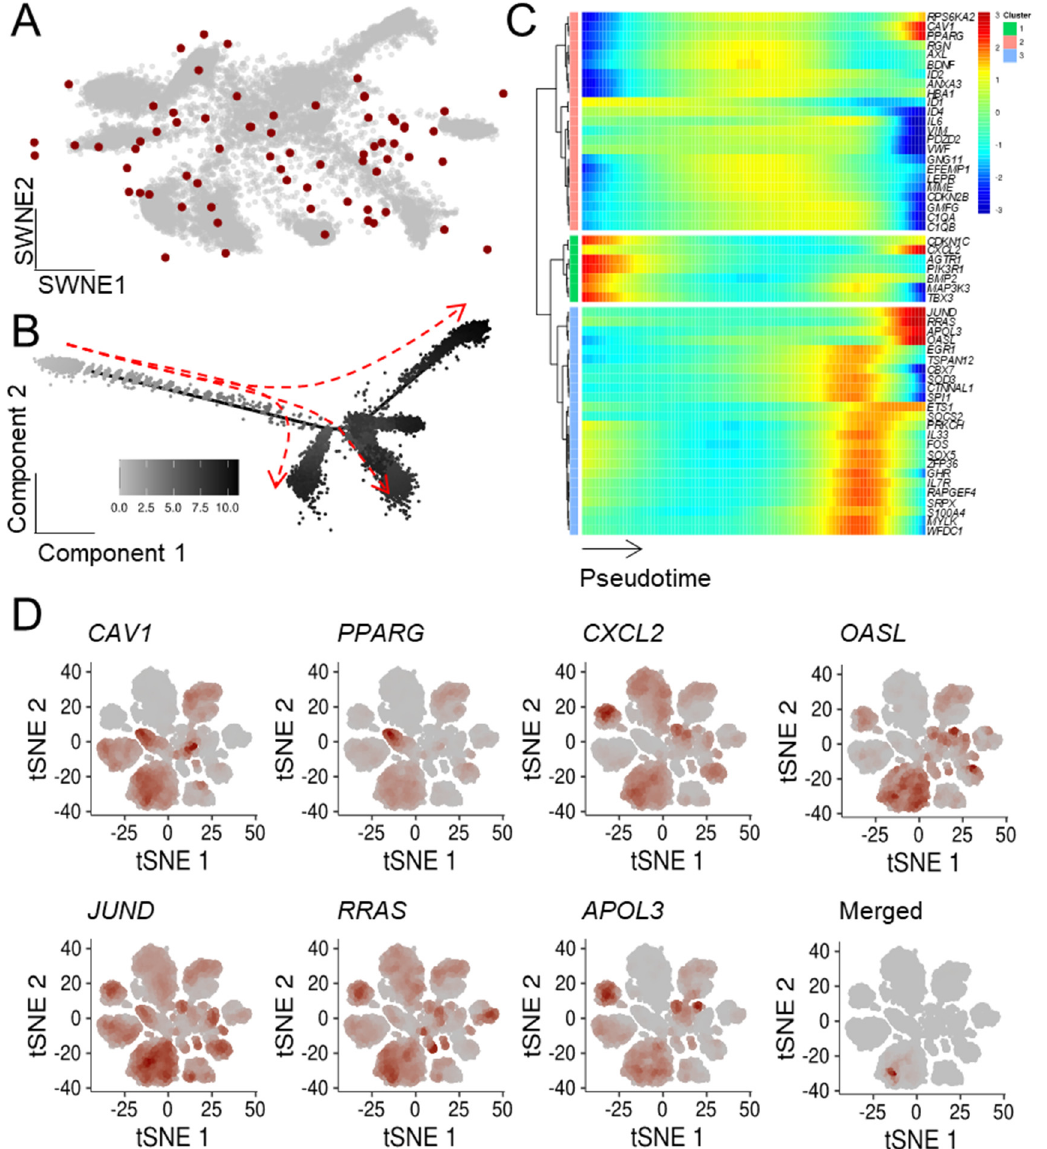
Figure 6. A subpopulation of lung adenocarcinoma cells displayed an upregulation of ASIGs with pseudotime. Malignant lung epithelial cells isolated from an LC scRNA-seq dataset containing samples of 11 tumors were analyzed (GSE131907 [50]). ( A ) The SWNE representation was weighted based on 69 previously defined ASIGs upregulated in LC (depicted as red dots). ( B ) Their developmental stage was depicted in pseudotemporal ordering, indicating an early (left, grey) and late (right, black) fate. ( C ) Several genes found in the blue and orange clusters displayed significant upregulation along pseudotime. ( D ) Cells expressing these genes formed a distinct cluster subpopulation as depicted in a t-SNE. Within 24 PDAC scRNA-seq samples (PRJCA001063 [53]), we aimed to identify ag- ing/senescence-associated patterns. We found an overlap of eight genes between both PDAC bulk mRNA-seq studies and the ASIGs (Figure 2A). These eight genes were de- picted in an SWNE plot with an overall homogenous appearance (Figure 7A) and pseudo-